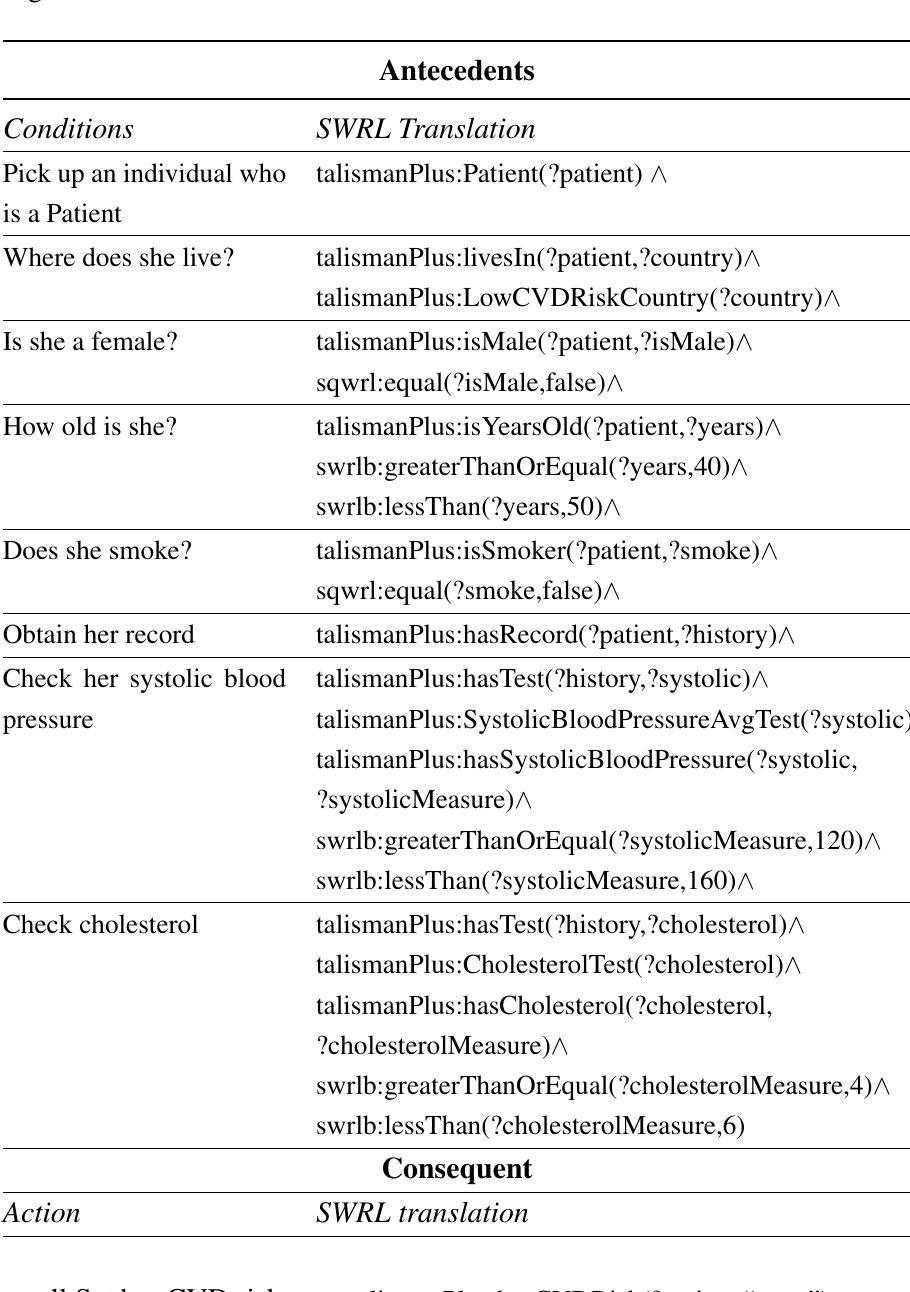
Table 2. Example of SWRL Rule based on SCORE for a 40-years-old non-smoker woman who lives in a low CVD risk country, whose systolic blood pressure is between 120 and 160 mmHg and whose cholesterol is between 4 and 6